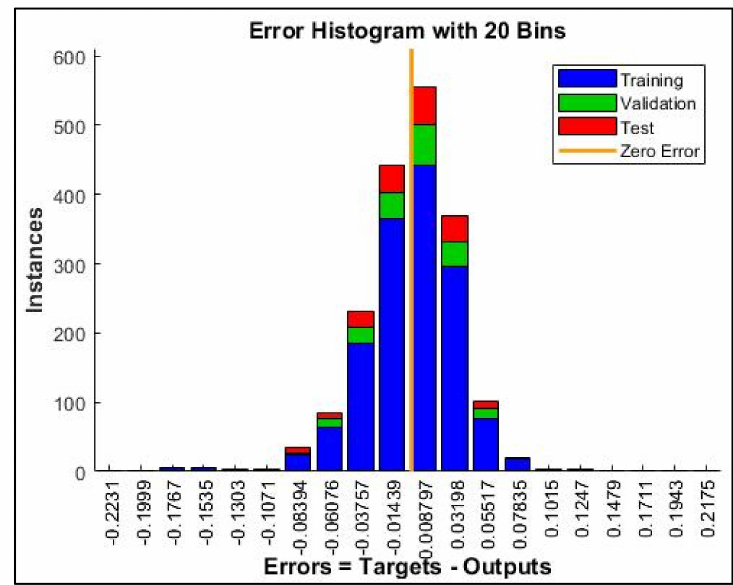
Figure 8. Training state of Model 7.